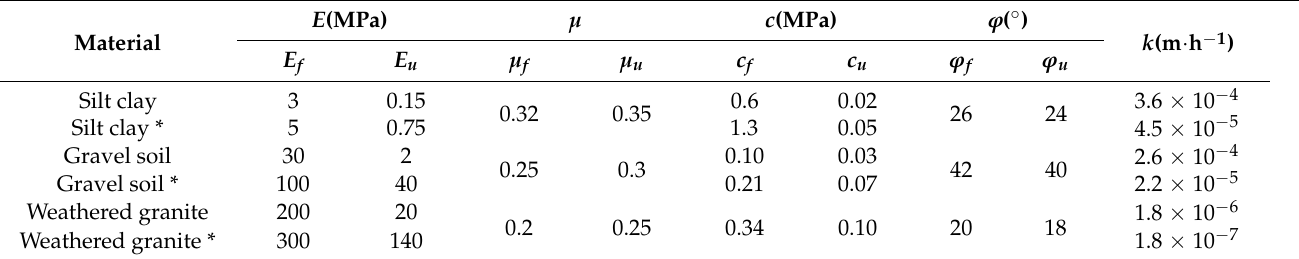
Table 3. Mechanical parameters of soils used for the proposed